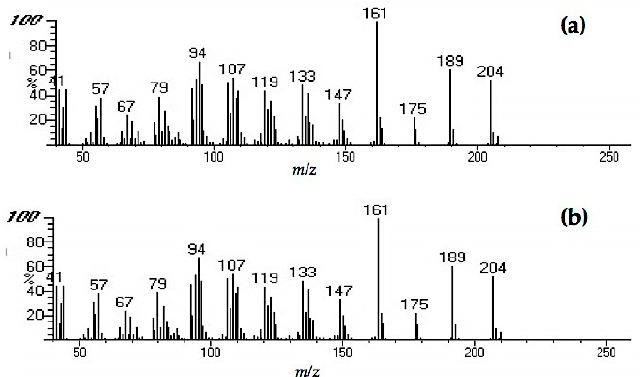
Figure 4. Mass spectra of peak 1 (retention time (RT) 21.11) from ( a ) crude decayed wood extract and ( b ) from n- hexane fraction after chromatography.